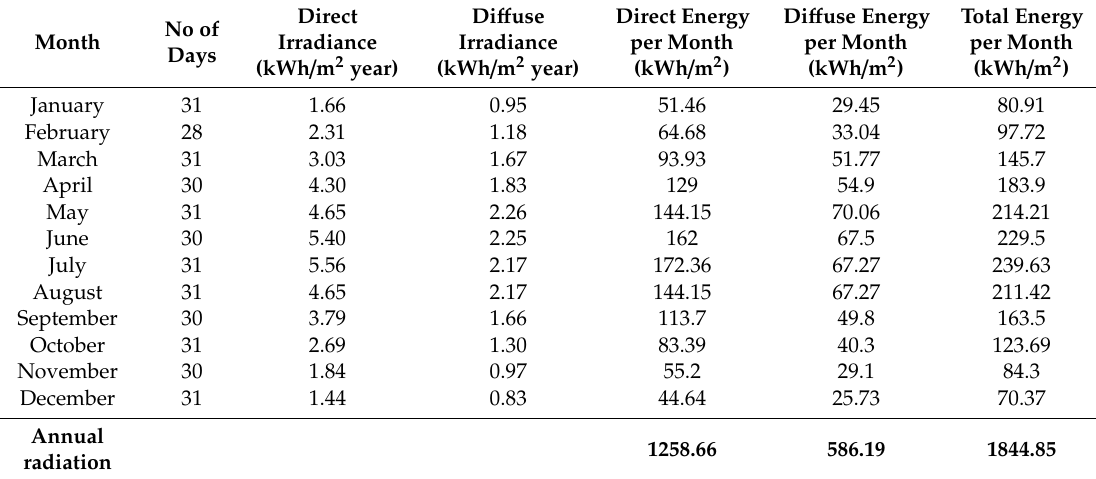
Table 4. Solar energy received per days, months and year.